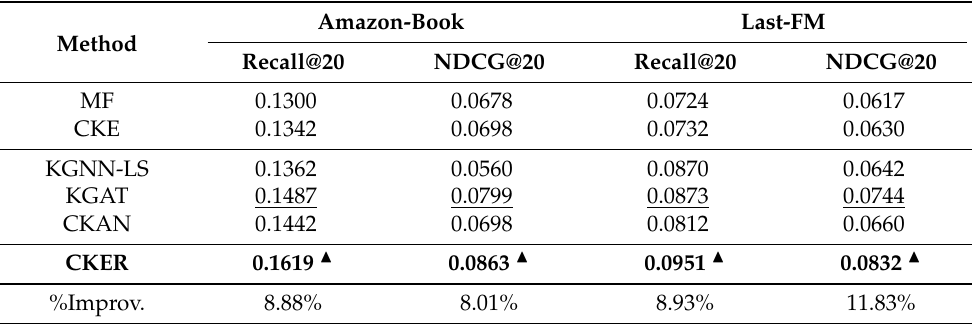
Table 4. Model performance. The results of the best performing baseline and the best performer in each column are underlined and boldfaced, respectively. CKER over the best baseline, using a paired t -test ( p <